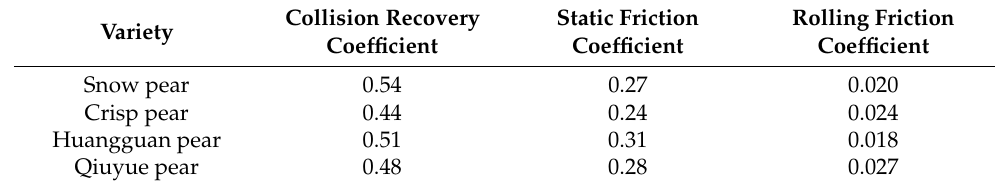
Table 15. Simulation parameters of pears.